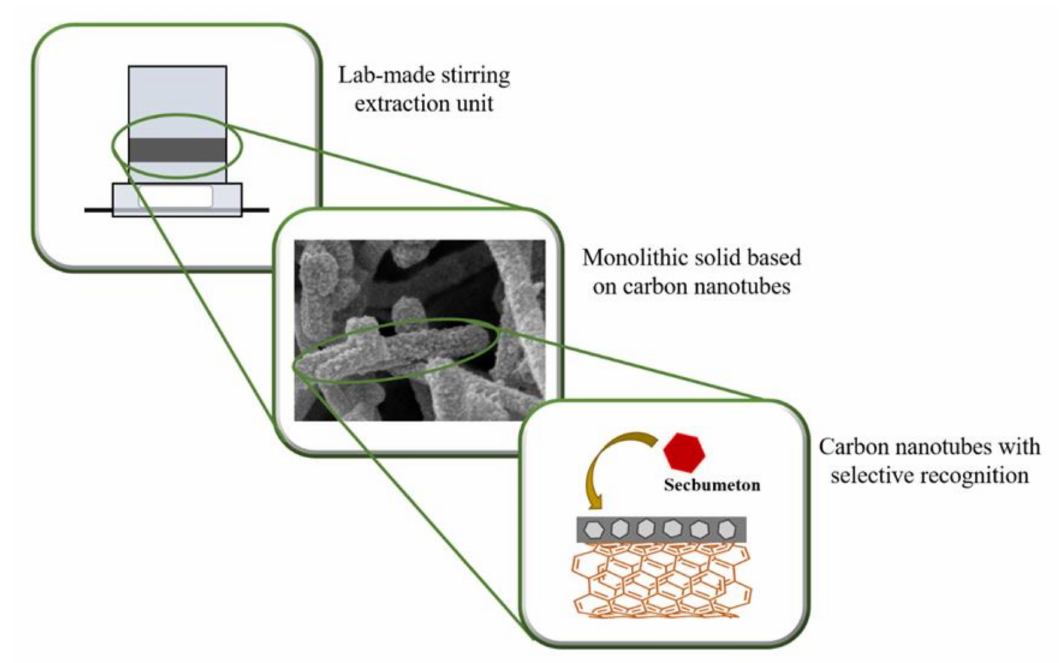
Scheme 1. Main elements of the molecularly imprinted polymer stirring unit synthesized by interconnected carbon nanotube monolithic sorbent in a polypropylene cap using secbumenton as a template. Reproduced with permission from